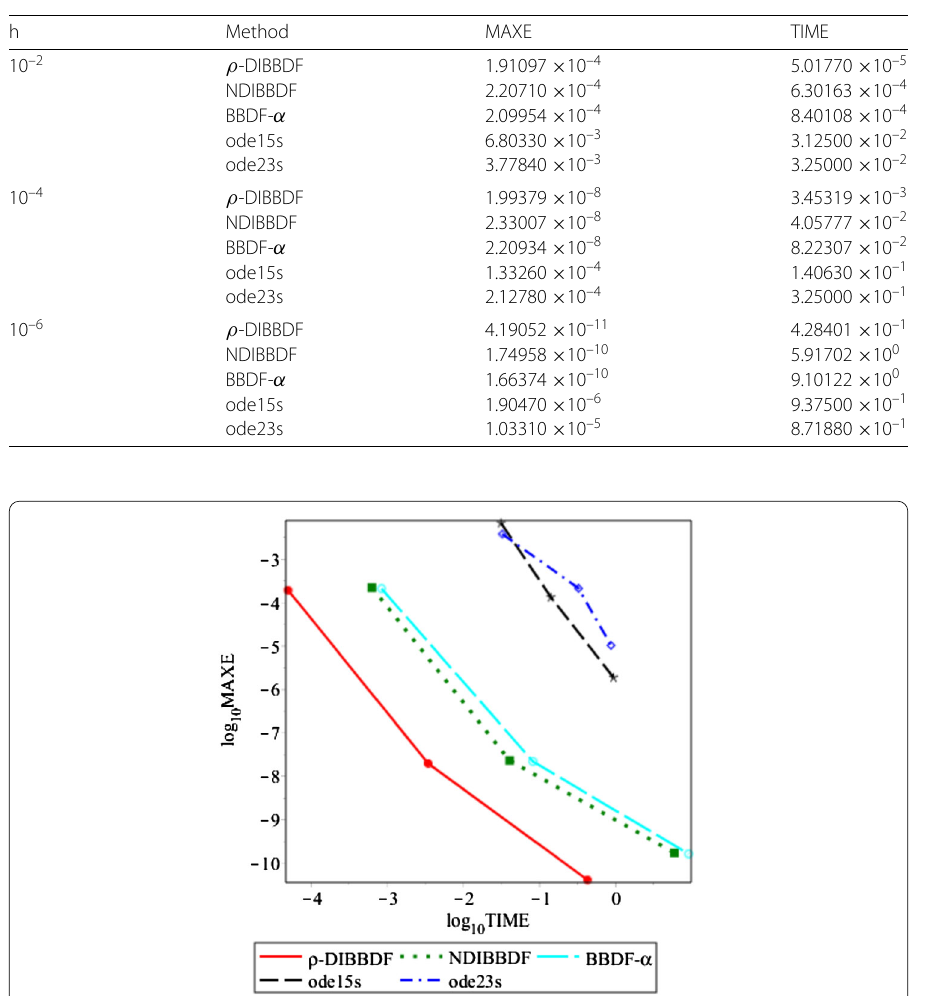
where t is the t th component of the total number of steps; T , i is the i th component of the number of equations; N and y i and y ( x i ) are the approximated and exact solutions, respectively. The abbreviations used in Tables 4–10 are described as